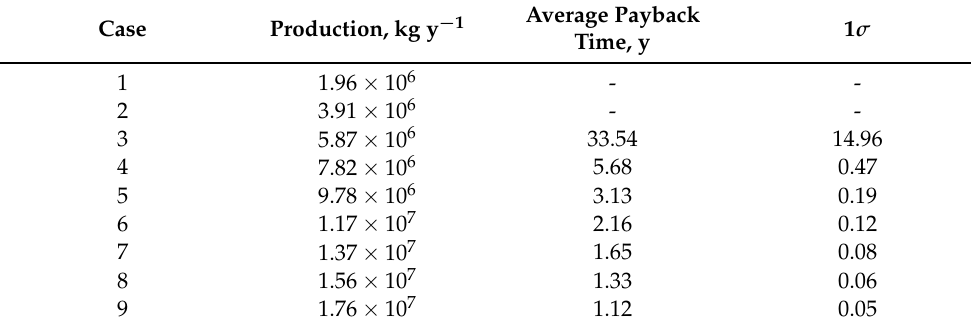
Table 5. Payback time ( PT , y) correlates with the hydrocarbon production ( P , kgy − 1 ), ln ( PT ) = 28790000 ± 2036000 − 1.64 ± 0.21, R 2 = 0.97. With a production of 1.05 × 10 7 kgy − 1 , the MRU breaks— P even 3y after its installation.